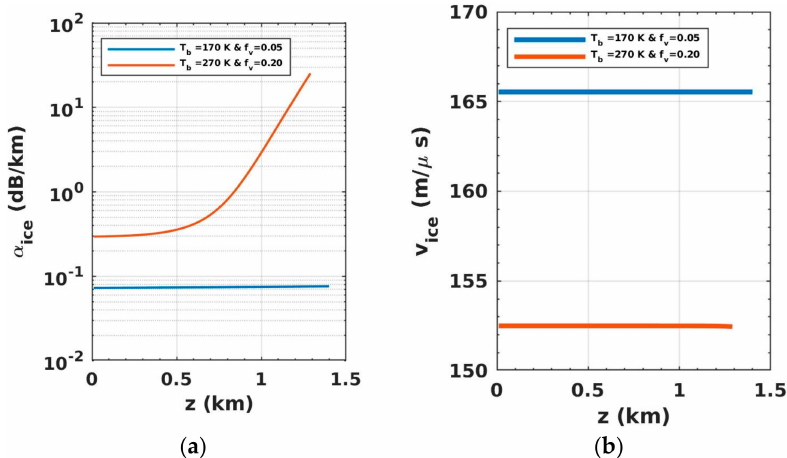
Figure 3. ( a ) Ice attenuation; ( b ) ice-layer velocity profiles for the extreme values of the investigated interval of the model parameters ( f v = 0.05, T b = 170 ) and ( f v = 0.2, T b = 270 ) . The two cases represent a cold quasi pure ice-layer and a warm dirty ice layer,